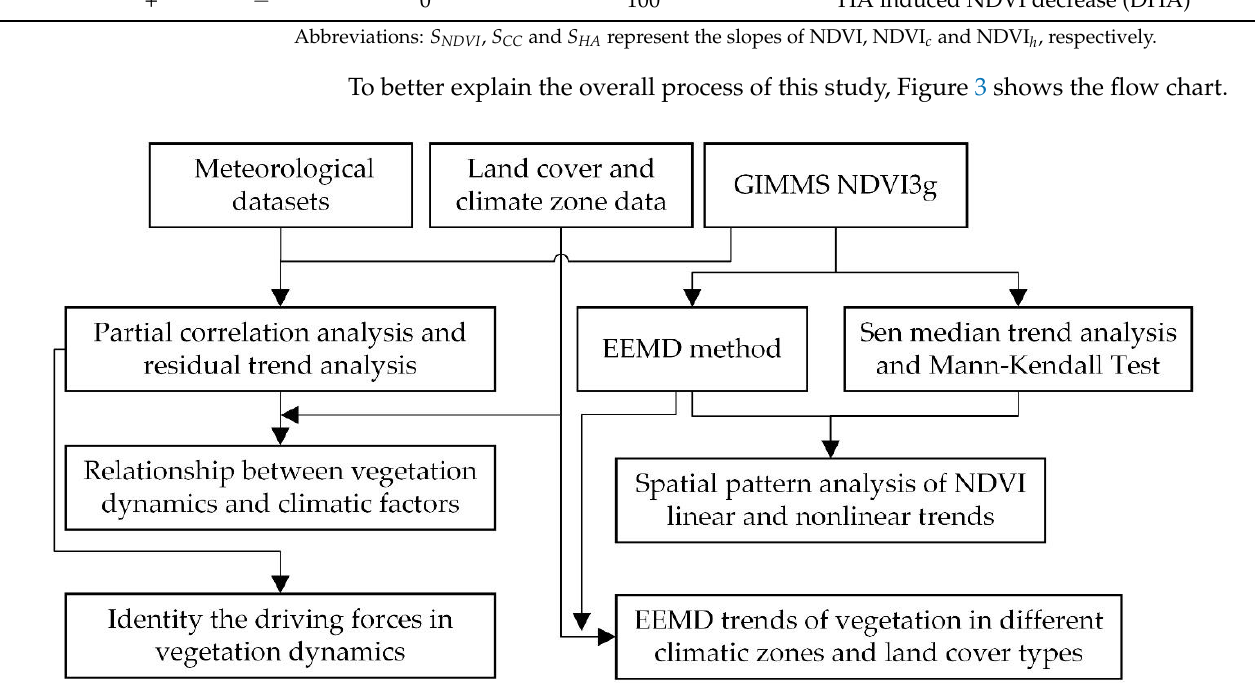
Figure 3. Flow chart of the NDVI analysis methods and processes in the study area.